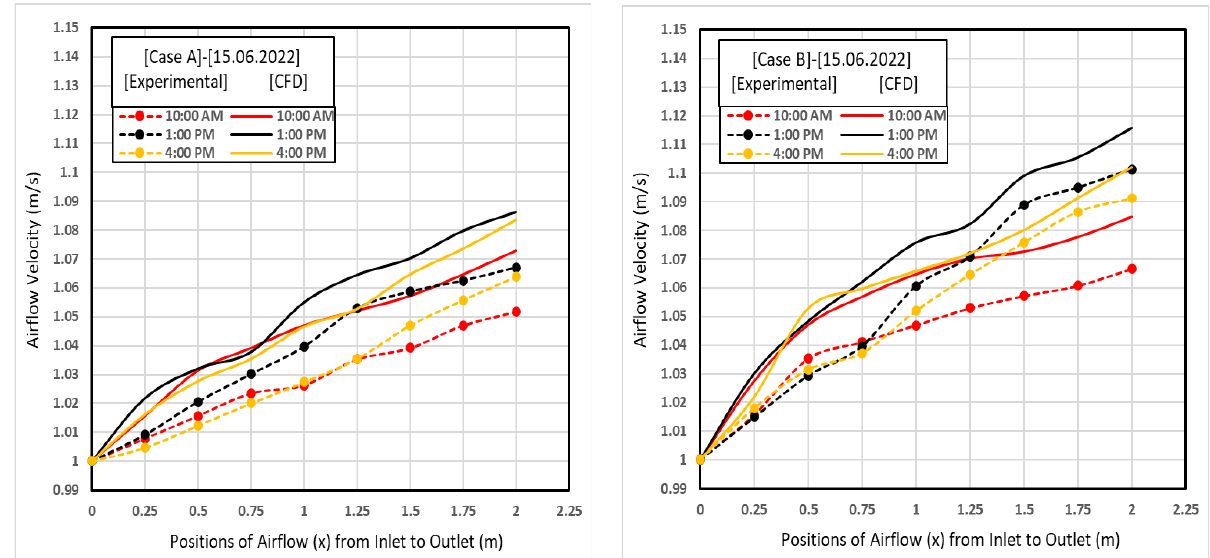
Figure 17. Validation of the variation in the CFD airflow velocity and the experimental data for the Case A and Case B FPSAHs tested at various time intervals.